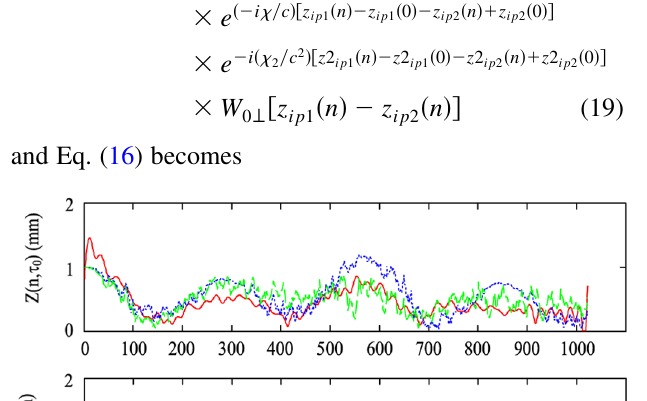
FIG. 12. (Color) Plot of measured and simulated envelope of Z (cid:3) n; (cid:1) (cid:4) versus n turns. Shown is the (vertical) transverse enve- lope of the turn-by-turn data for the tail after a 1 mm kick. The (cid:5) 4 nsecs ). The red tail is 4 ns away from the bucket center ( (cid:1) 0 trace is actual vertical data, blue simulation with resistive wall (cid:5) 19 cm 1 : 5 , chromaticity (cid:4) (cid:5) 3 : 7 , bunch length wake W 1 ? (cid:5) 3 ns , second order chromaticity of (cid:4) 0 (cid:5) (cid:1) 3400 only. (cid:8) (cid:1) The green trace shows the effect of adding Eq. (21) correction to the synchrotron